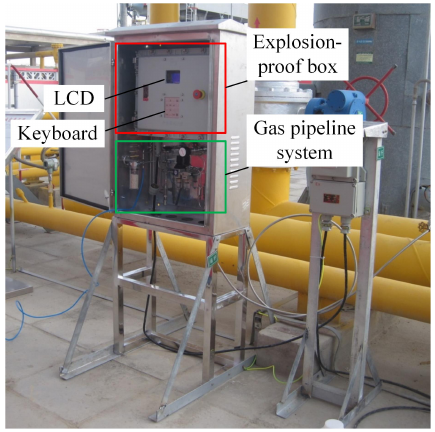
Figure 7. Field work of the mixed natural gas monitoring